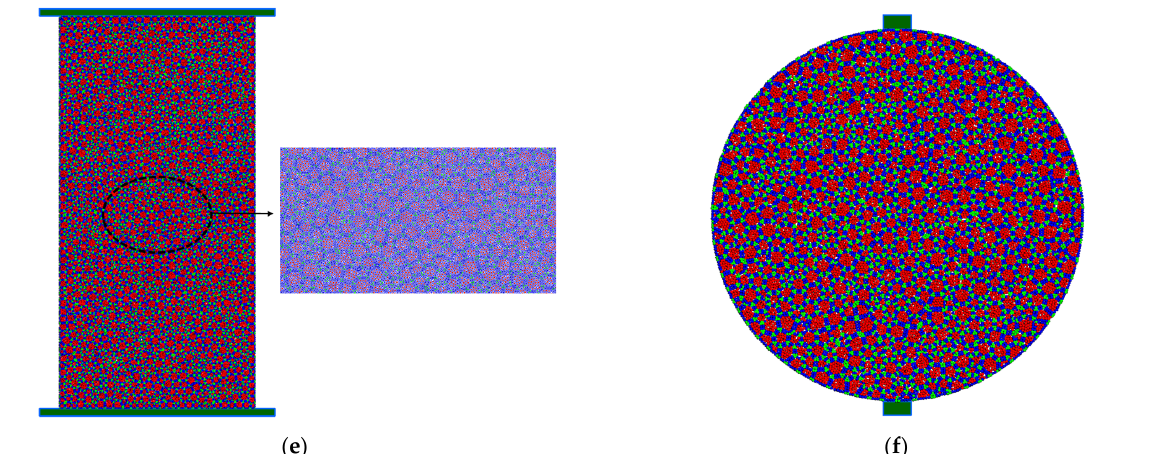
Figure 5. Particle assemblies: ( a ) uniaxial and biaxial tests (Rigid PM model); ( b ) Brazilian test (Rigid PM model); ( c ) uniaxial and biaxial tests (proposed flexible PM model); ( d ) Brazilian test (proposed flexible PM model); ( e ) uniaxial and biaxial tests (Rigid PM-inner contacts) and ( f ) Brazilian test (Rigid PM-inner contacts).